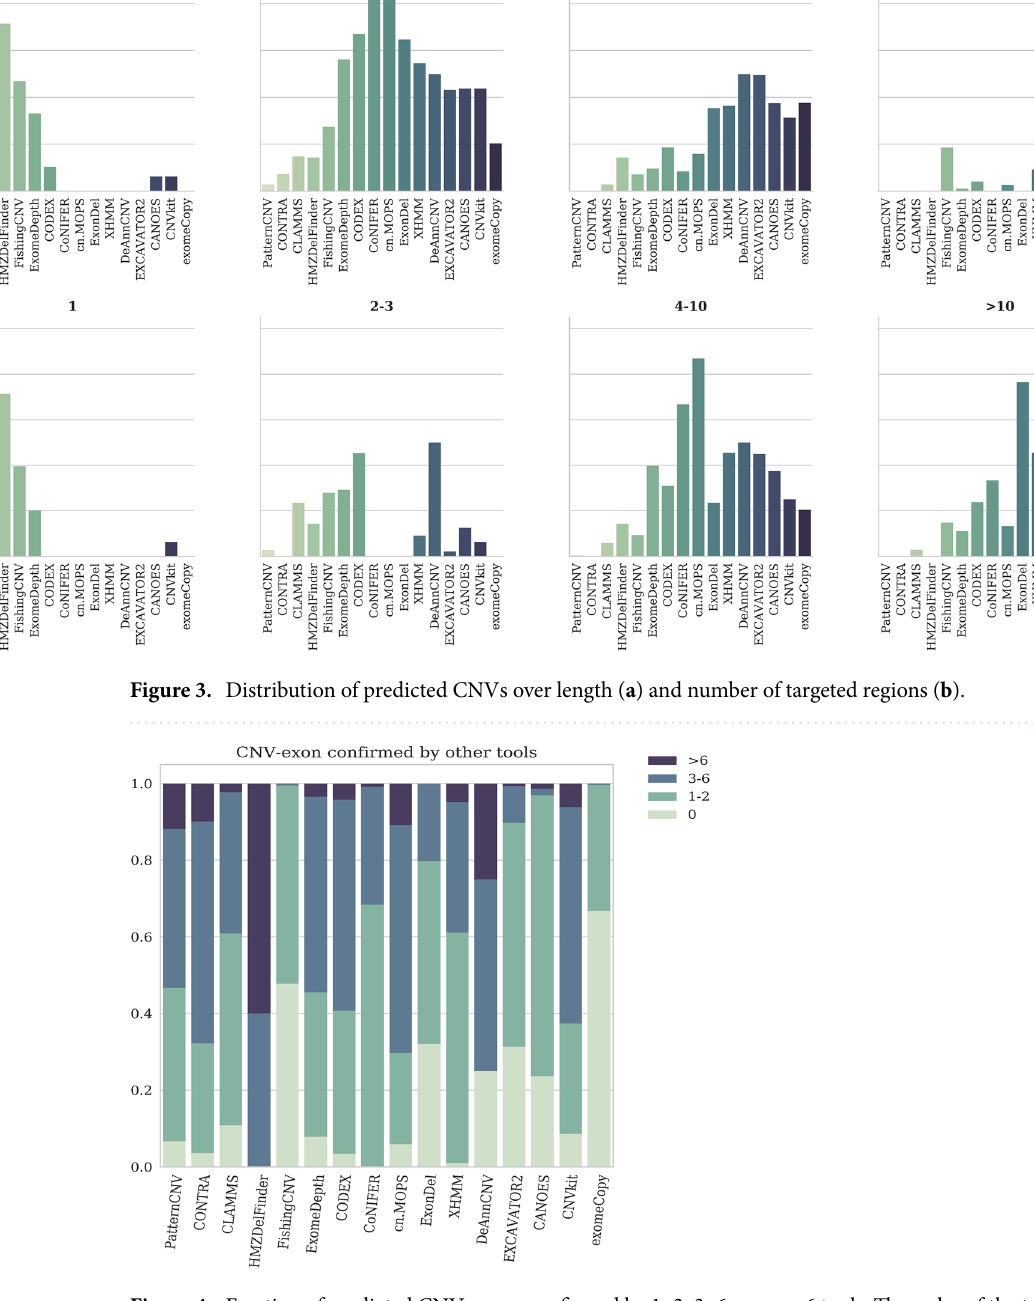
Figure 4. Fraction of predicted CNV-exons confirmed by 1–2, 3–6, or over 6 tools. The order of the tools is determined by the length of predicted CNVs: from small to